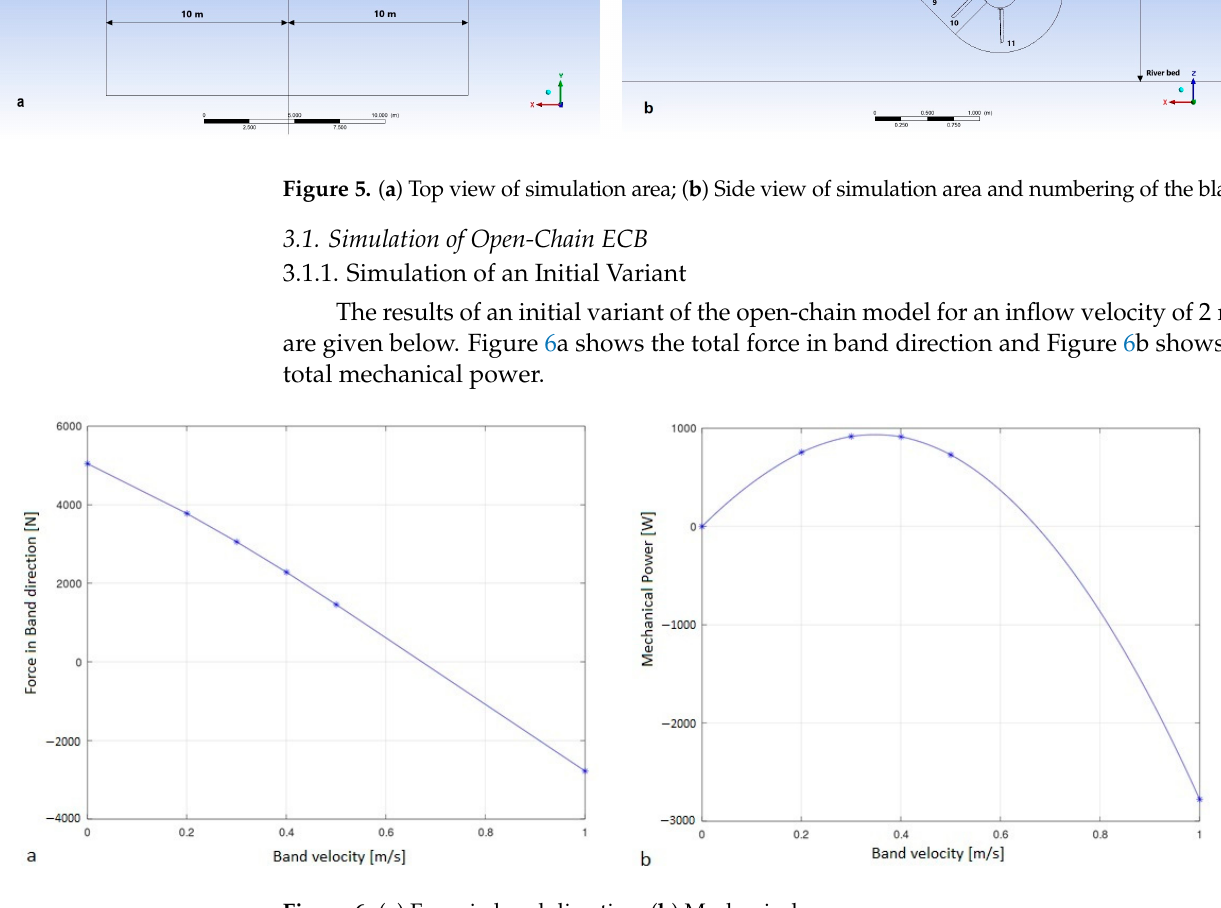
Figure 6. ( a ) Force in band direction; ( b ) Mechanical power.